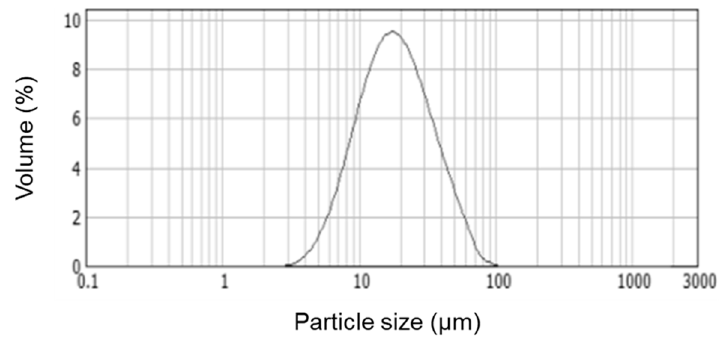
Figure 1. Particle size distribution of the silica (SiO 2 ) microparticles, as received.